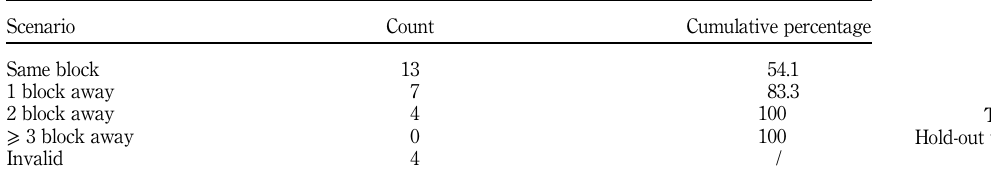
Table IV. Hold-out validation